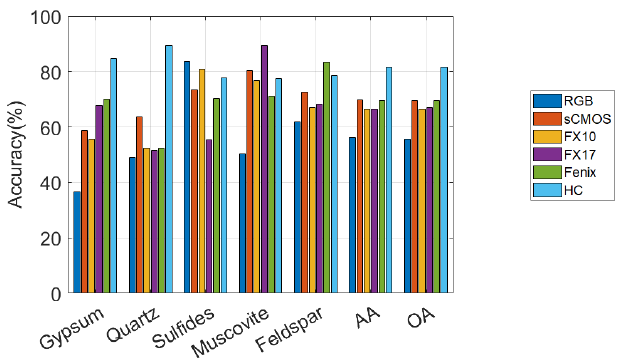
Figure 5. The performances of different optical sensors on different minerals in terms of accuracy in percentage obtained by applying SVM on the spectral bands of the TS4